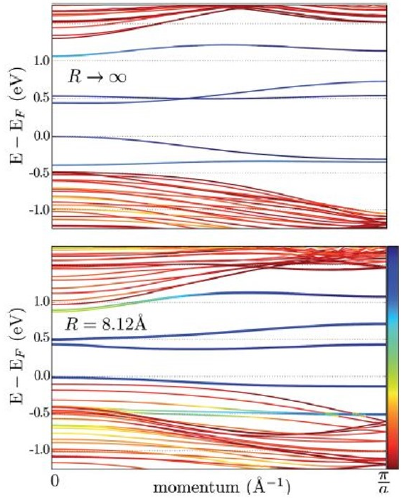
Figure 1. Band structure of a flat (upper panel) and a bent (lower panels) MoS 2 nanoribbon [35]. The different color shows the location of the eigenvalues: The inner subbands (i.e., bulk-like) and the edge subbands are red and blue, respectively; the hybridization of bulk and edge states are between red and blue.